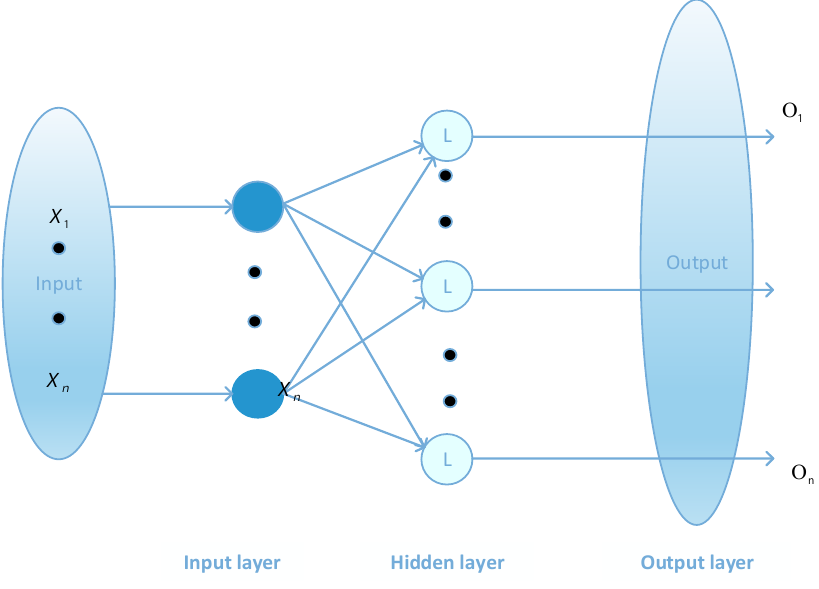
Figure 1. BP neural network structure diagram.